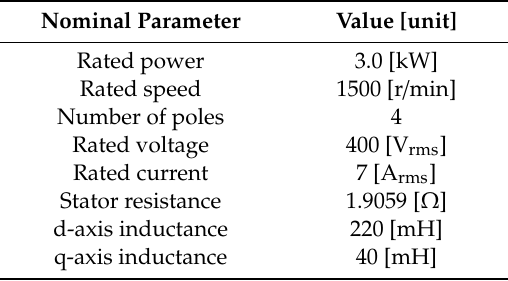
Table 1. Nominal parameters of the 3 kW SynRM.